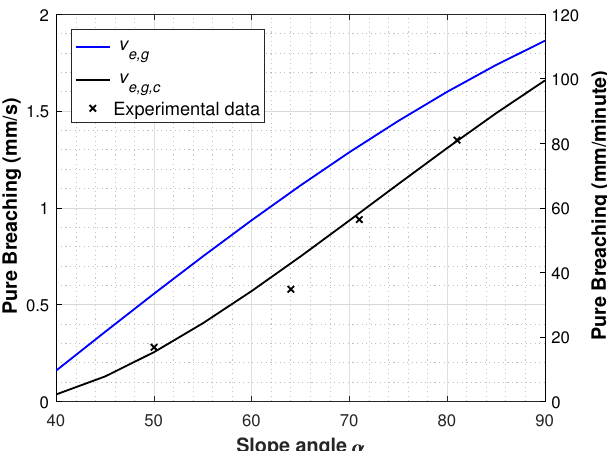
Figure 1. Comparison between the predictive ability of the original (Equation (13)) [18] and empirically corrected (Equation (14)) relations of pure breaching: d 50 = 0.135 mm, n 0 = 0.40, n l = 0.51, φ = 36 ◦ and k l = 0.0307